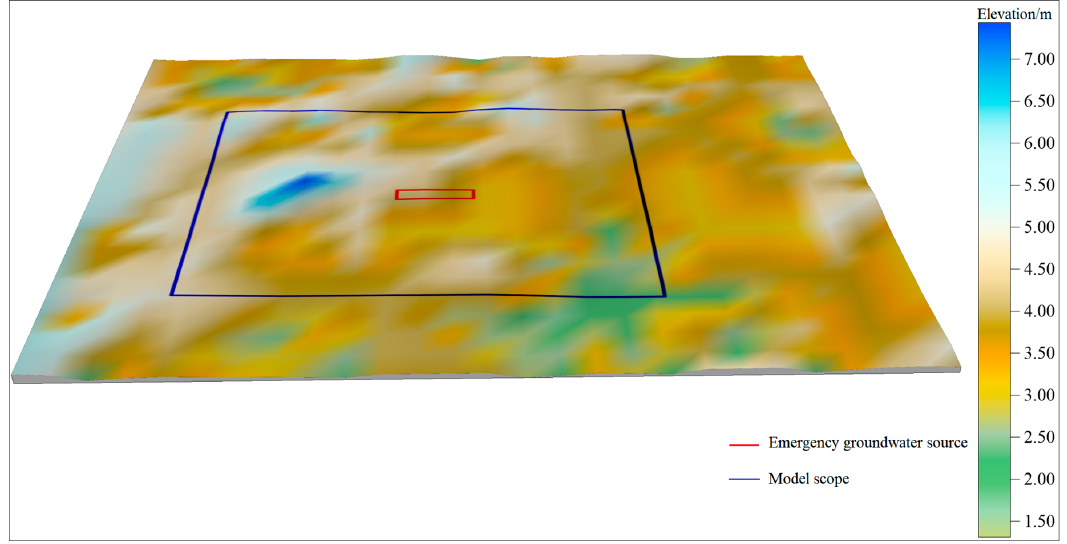
Figure 2. Topographic map of the study area.